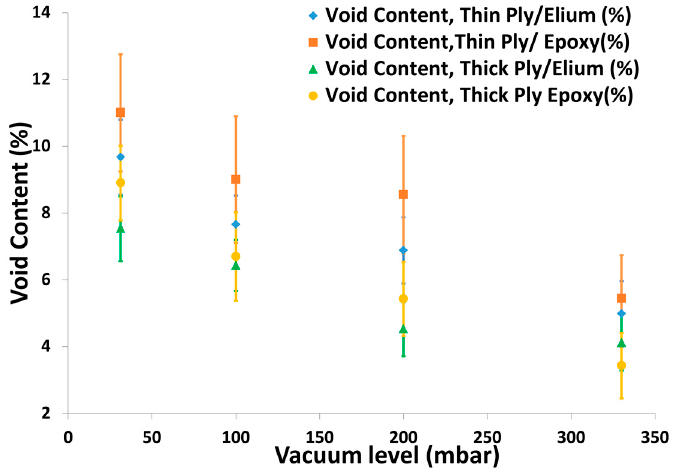
Figure 9. Void Content vs. vacuum level for thick and thin C-Ply™ with TP and TS matrices.